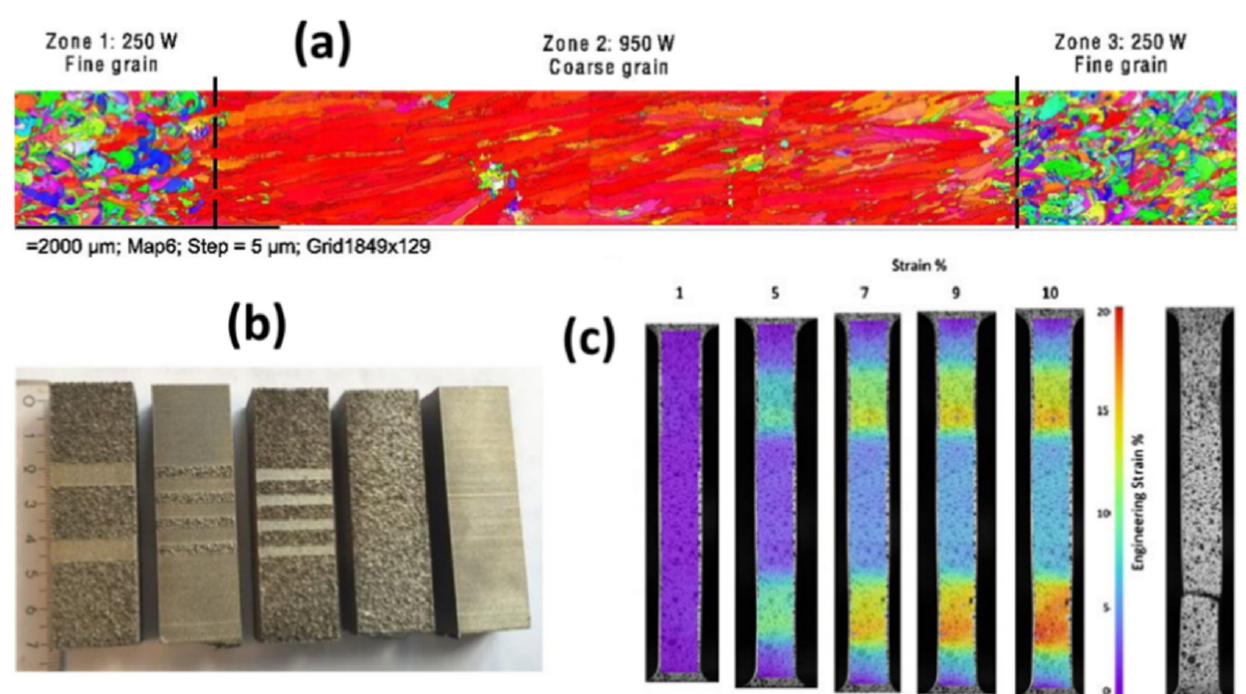
Figure 29. ( a ) EBSD analysis of a graded Inconel 718 specimen with a single coarse columnar grained zone embedded in a fine-grained matrix. ( b ) Pictures of different gradients in processed samples, depicting areas of 950 W (dark areas) and 250 W (bright areas). ( c ) Strain evolution as a function of crosshead displacement for the gradient with fine-grained matrix in the middle and coarse-grained regions on two sides